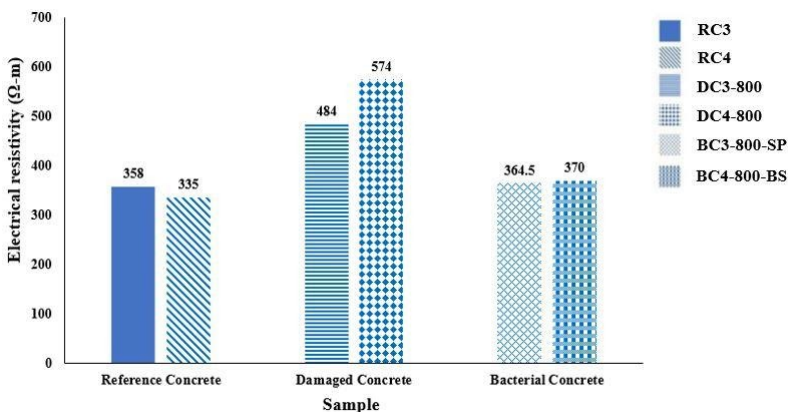
Figure 9. Comparing the bulk electrical resistivity results of the control specimens, damaged at 800 °C and repaired by type I and II bacteria.